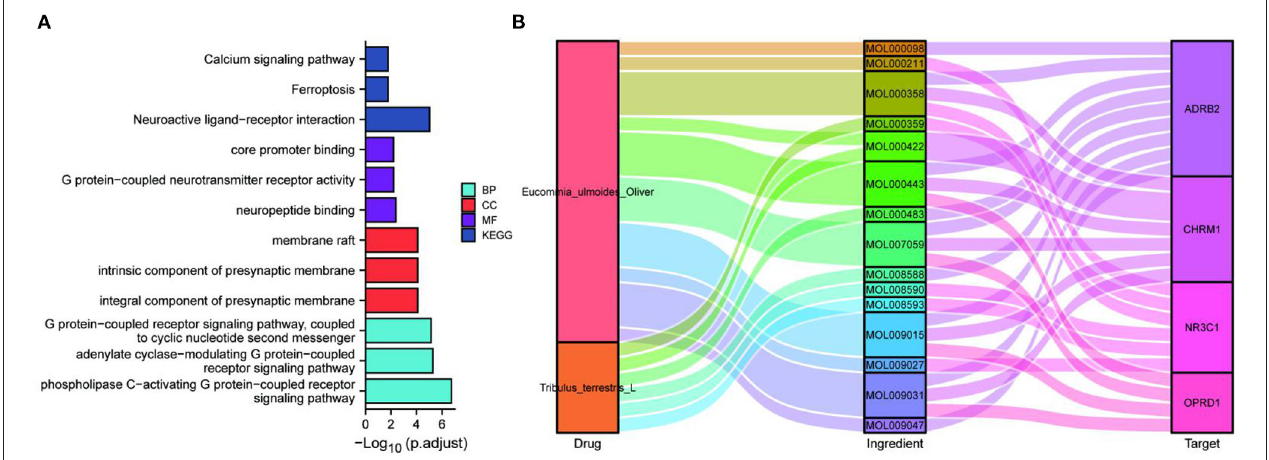
FIGURE 3 | Network construction and pathway analysis of the active ingredient-pathway targets. GO and KEGG enrichment analysis of the key proteins CHRM1, NR3C1, ADRB2, OPRD1, FTH1, TP53, and PCBP2 (A) ; Sankey plots were used to demonstrate the drug-active ingredients-key neuroactive ligand-receptor interaction pathway targets regulatory network (B) .